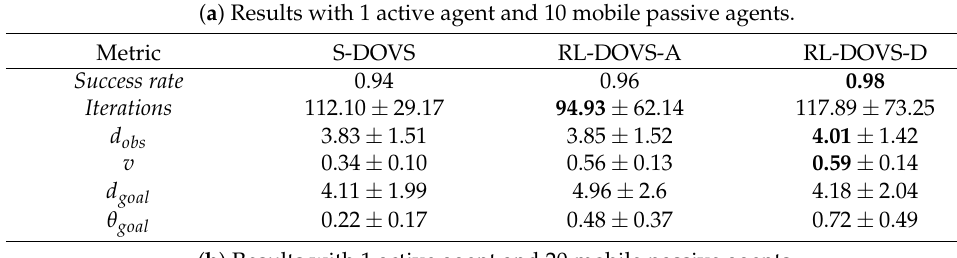
Table 6. Results with different numbers of active and passive